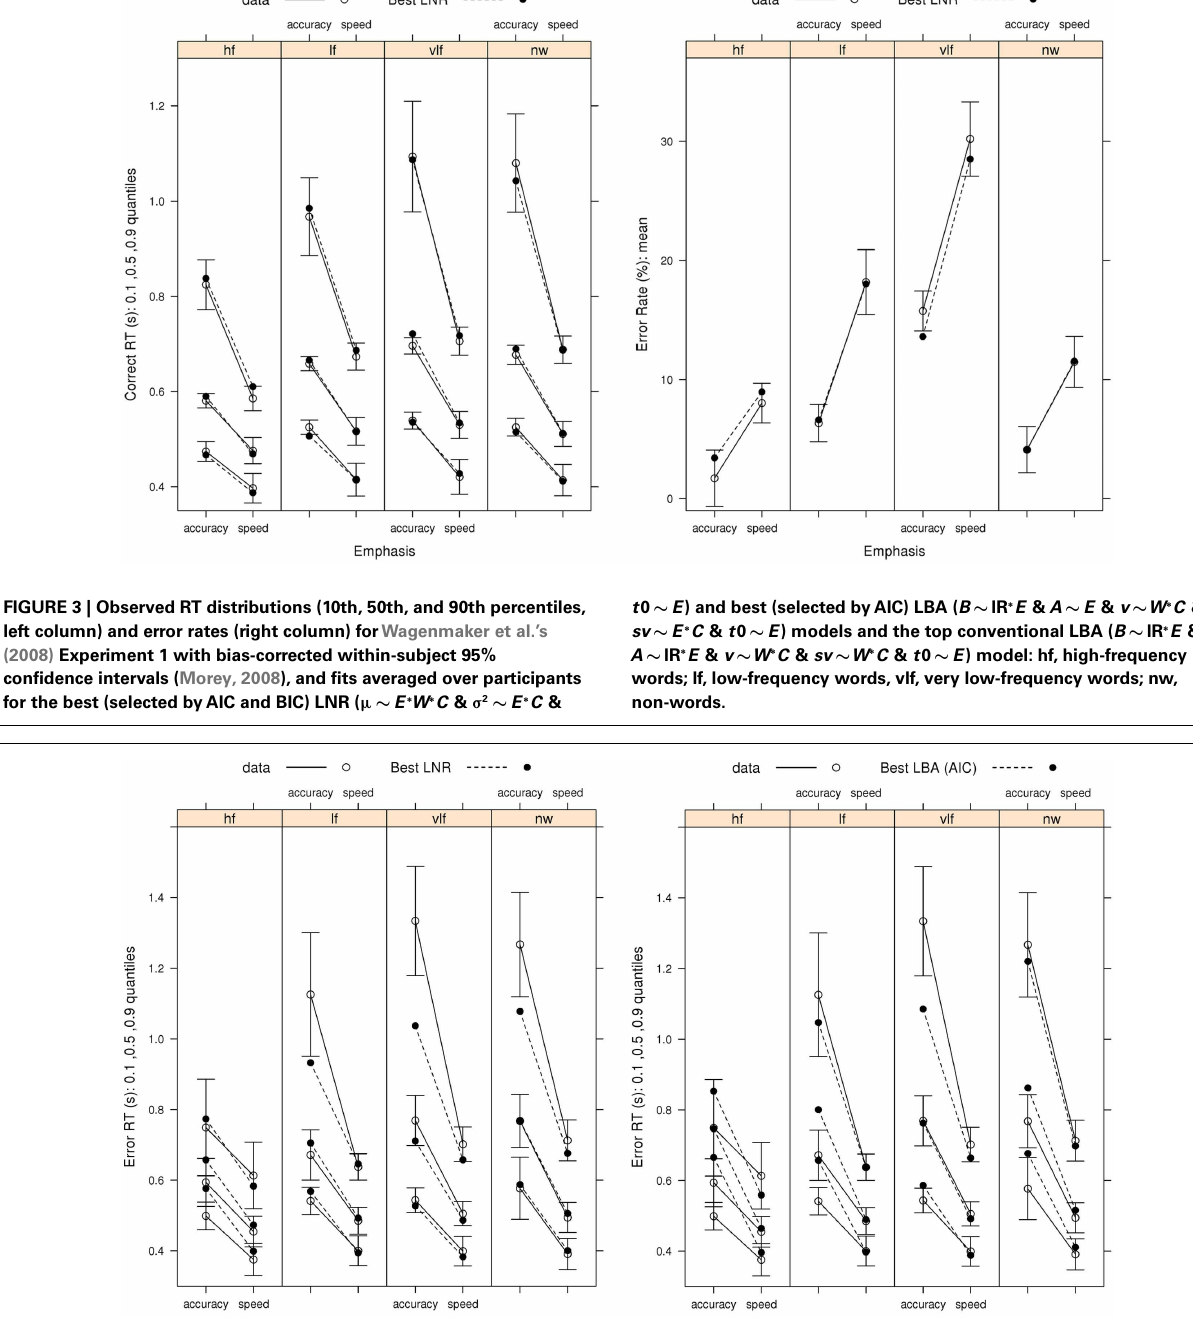
FIGURE 4 | Observed error-response RT distributions (10th, 50th, and 90th percentiles)Wagenmaker et al.’s (2008) Experiment 1 with bias-corrected within-subject 95% confidence intervals (Morey, 2008), and fits averaged over participants for the best (selected byAIC and